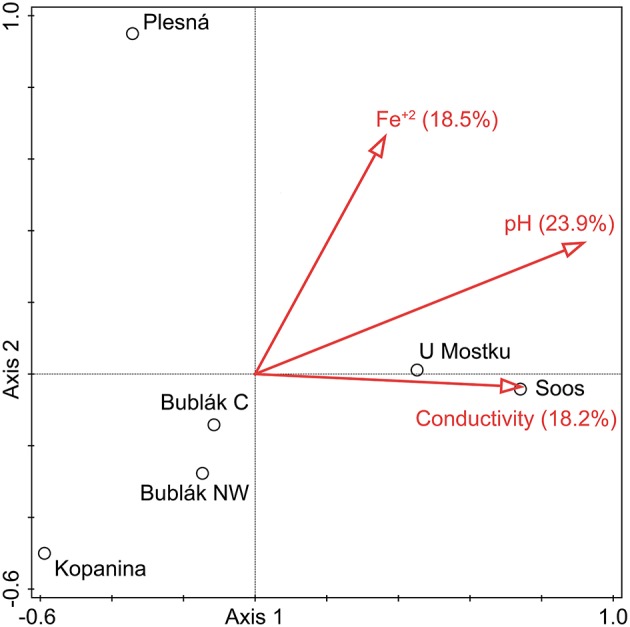
Canonical correlation analysis of the microbial composition on OTU level and environmental parameters. If the Bonferroni corrected padj was <0.05, a given parameter was included. Conductivity, pH and Fe2+ concentration explained 60.6% of the compositional variation among the investigated waters. Circles indicate sampling locations.